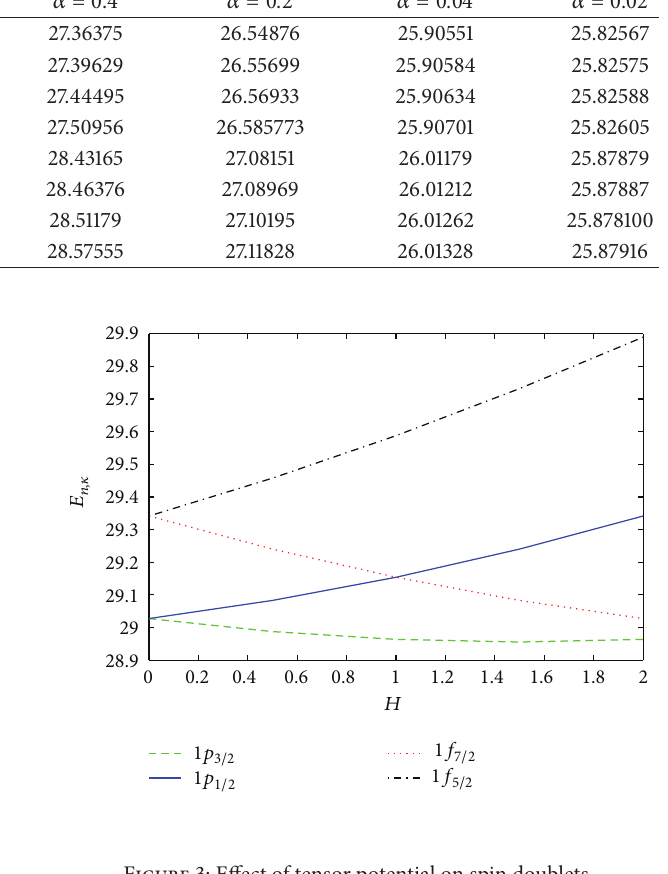
Figure 2: The centrifugal term 1/𝑟 2 (red line) and its approxima- tions (16) with 𝑑 0 = 0 (green dash line) and 𝑑 0 = 1/12 (blue dot line), while 𝛼 = 0.002 fm −1 .